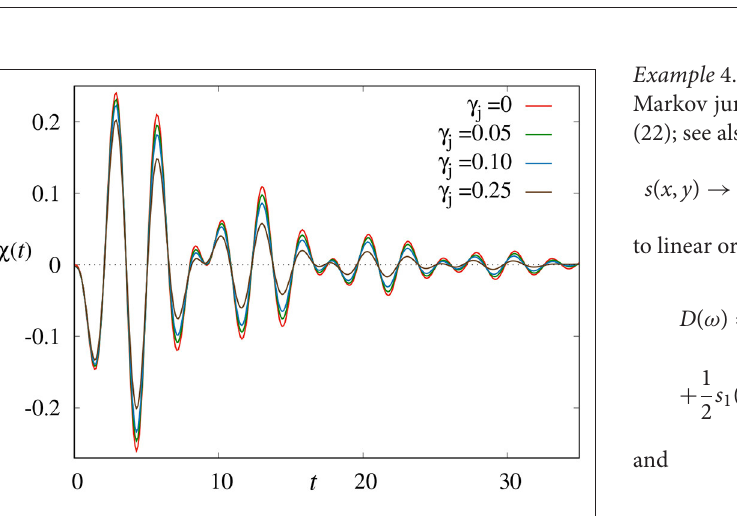
FIGURE 6 | The susceptibility (68) of p ( k ) for perturbing at q ( j ), for different γ n values of γ j with T j 1.5 and γ 1 1, T 1 2, and T n 1; all other = = = = = γ i 0. A small perturbation of the mass at site j causes a damped oscillatory ≡= movement of the mass at site k . Interestingly, the limit in which the damping γ j 0 makes sense, erasing the thermal noise in the bulk. The plot refers to ↓ q ( i q ( i kq ( i ) with α q ( i ) 2 the dynamics (65) with force F i 2 q ( i ) 1) 1) = − + − + + − − α 1.0, k 2.0, and U 0. Figure courtesy of Urna = = =